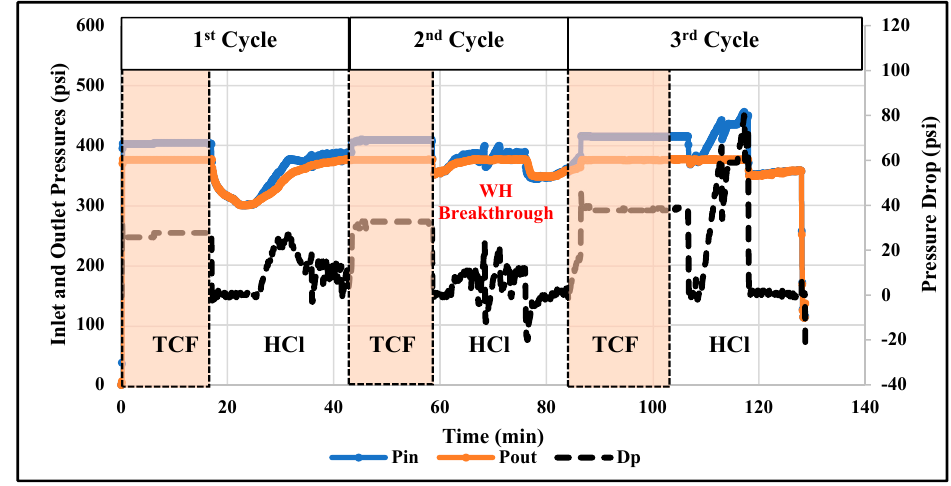
Figure 7. Profiles of inlet (Pin) and outlet (Pout) pressures and the pressure-drop across the low-permeability rock during alternating injection of thermochemical and HCl fluids. The pressure drop is read from the y-axis in the right-hand side. Molecules 2020 , 25 , 2976